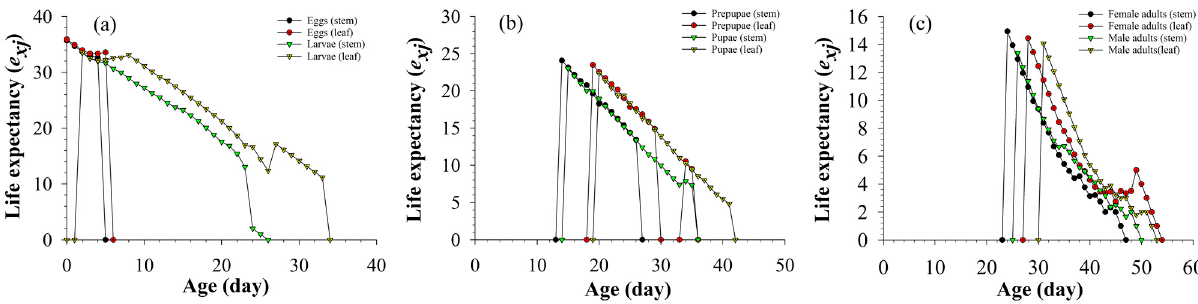
Figure 2. Population survival rate ( l x ) ( a ), fecundity of female adult ( f xj ) ( b ), population fecundity ( m x ) ( c ), and population maternity ( l x m x ) ( d ) of S. litura fed on different tissues of asparagus.